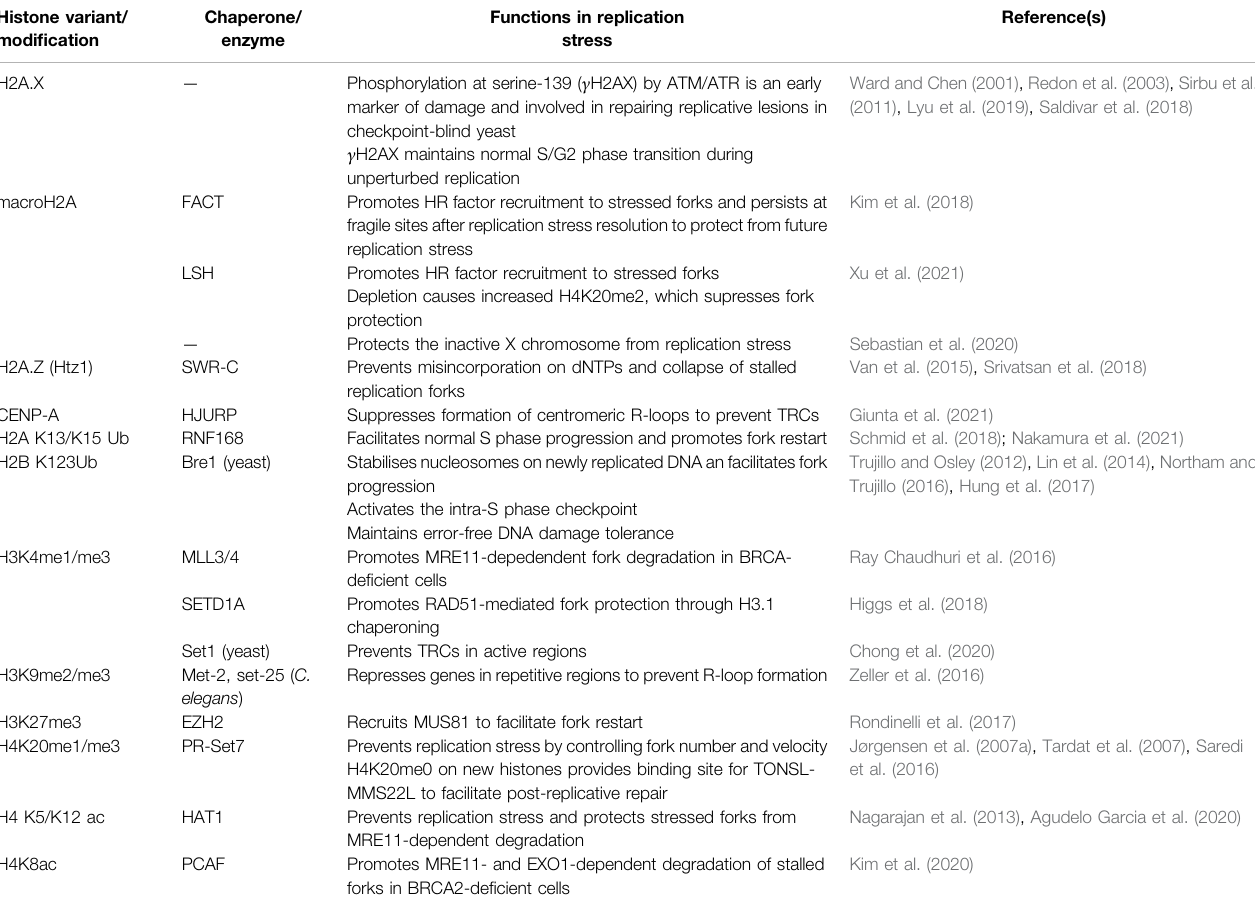
TABLE 1 | The roles of histone variants and modi fi cations in replication stress. Histone variant/ modi fi